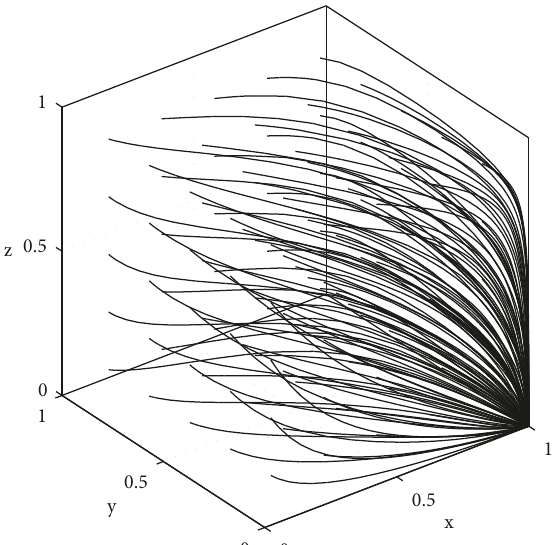
Figure 4: Dynamic evolution path of case 3.